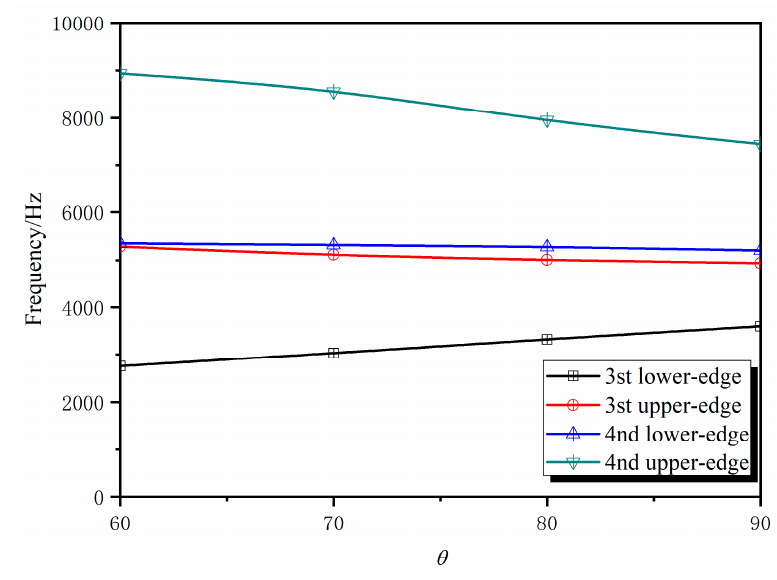
Figure 7. Band gap cut-off frequencies of the 3D star structure at different θ .